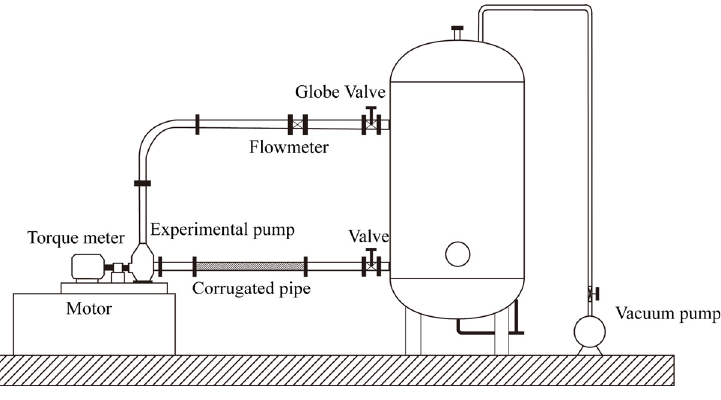
Figure 7. Schematic diagram of the test rig.